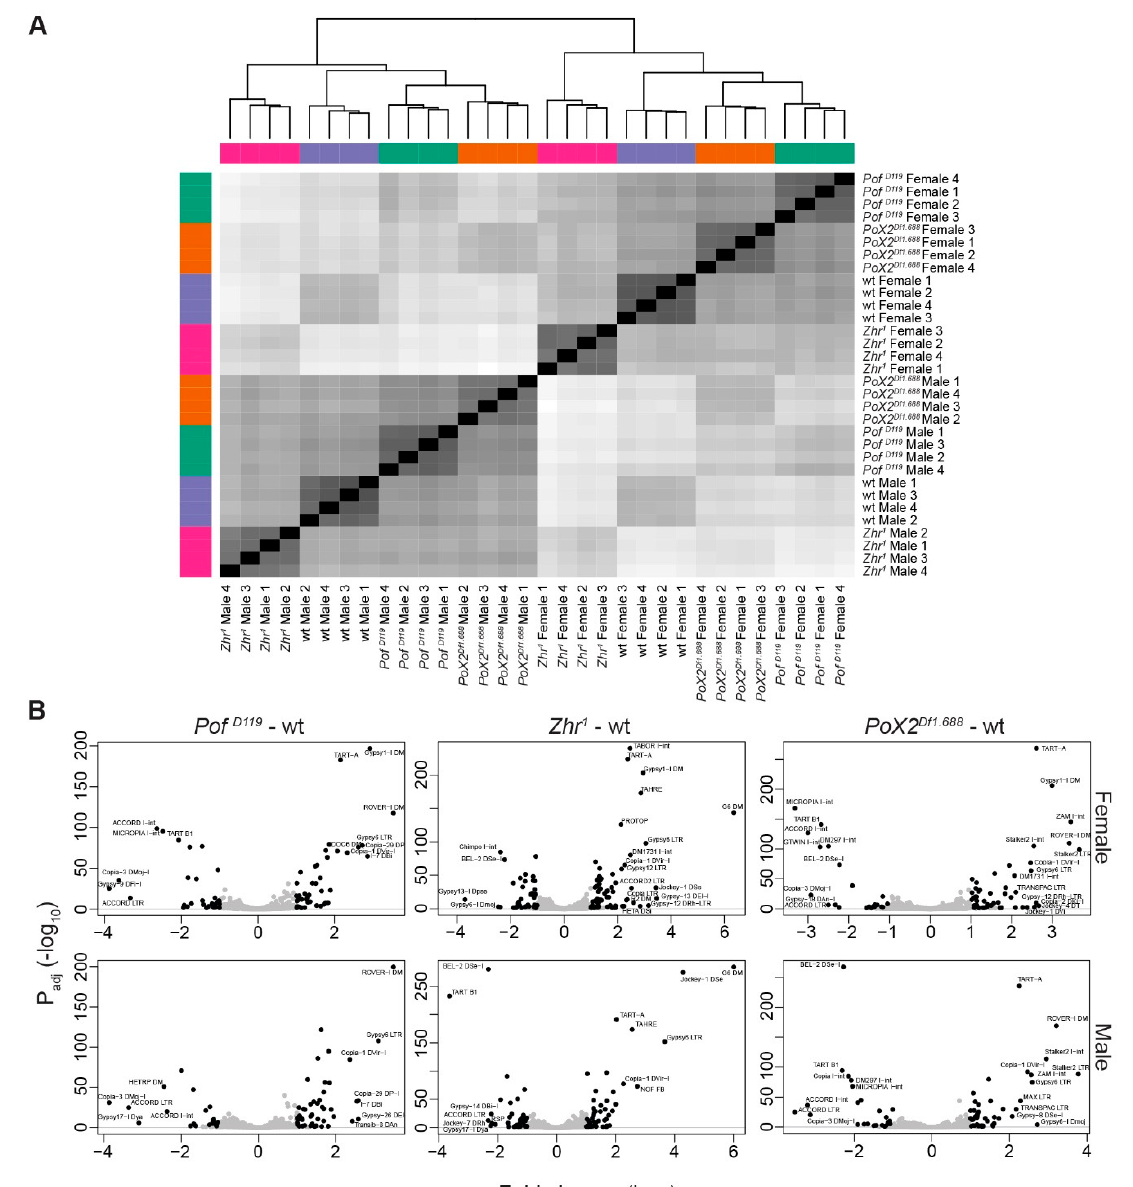
Figure 7. Genome-wide transposon analysis in mutants versus wild type. ( A ) Sample distance analysis based on RLT read counts of transposons cluster samples by sex and genotype. ( B ) Volcano plots of differentially expressed transposons. Transposons were predominantly de-repressed in Zhr 1 mutants, especially in females. Dots are coloured in black if significant ( P adj ≤ 0.05 and up/downregulation log 2 fold change ≥ 1), otherwise grey. Labels are shown for black dots which also have up/downregulation log 2 fold change ≥ 2. Labels were moved manually to avoid text overlaps and redundant labels were removed.